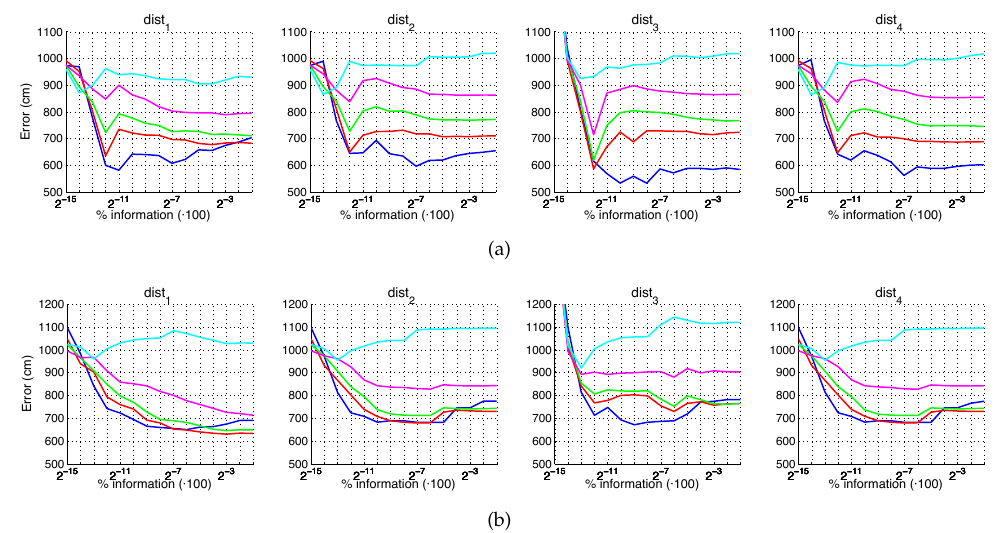
Figure 21. FS average localization error with occlusions: ( a ) no filter and ( b ) homomorphic filtering. Legend: —– Original, —– Occlusion 1, —– Occlusion 2, —– Occlusion 3, —– Occlusion 4.